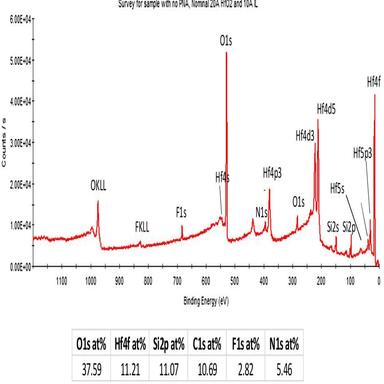
Survey and quantification of a HfO2 film with nitridation and no PNA, nominal 20A HfO2 and 10A Chem-Ox IL.